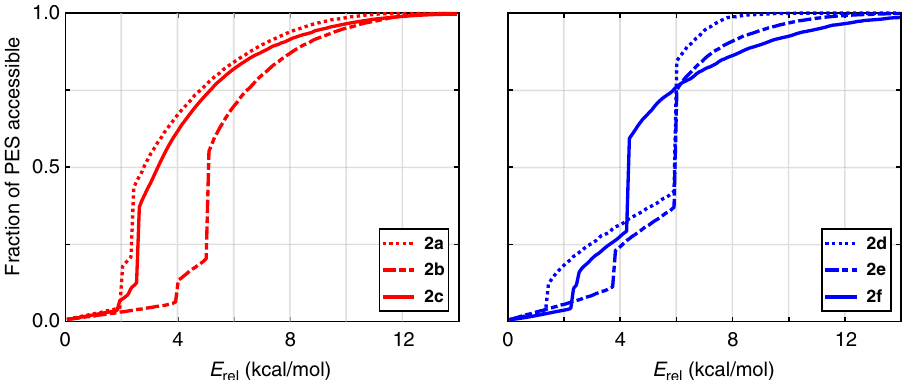
Fig. 4 Rotational PES accessibility. Fractional area of the 2D rotational PES depicted in Fig. 3c that is accessible from the respective global minima corresponding to the tricyclic ( 2a – 2c , left panel) and phthalic ( 2d – 2f , right panel) model compounds as a function of the energy ( E rel ) available for traversing rotational barriers (Supplementary